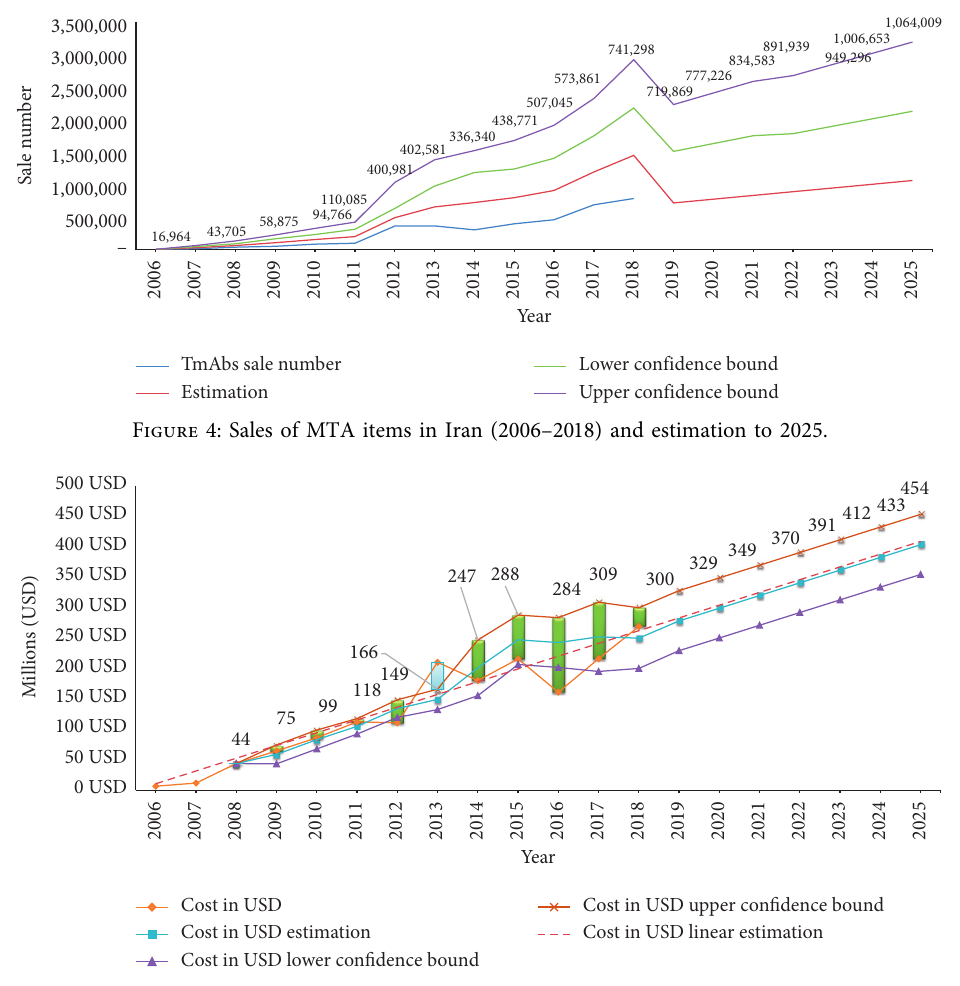
Figure 5: The cost of MTAs in Iran (2006–2018) and estimation to 2025.